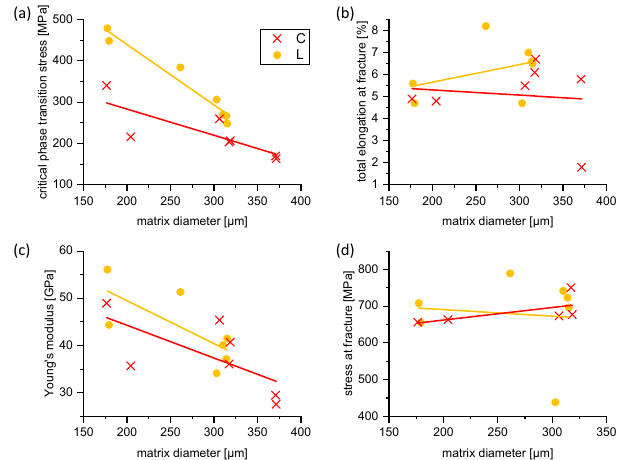
Figure 9. Critical phase transition stress ( a ), total elongation at failure ( b ), Young’s modulus ( c ) and stress at failure ( d ) plotted as a function of matrix diameter (strut diameter). The lines are intended to guide the eye of the reader and do not represent linear fits.